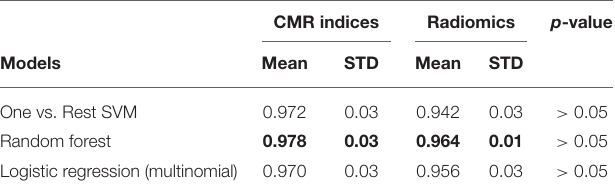
TABLE 4 | Summary table of the testing performance of the selected models.